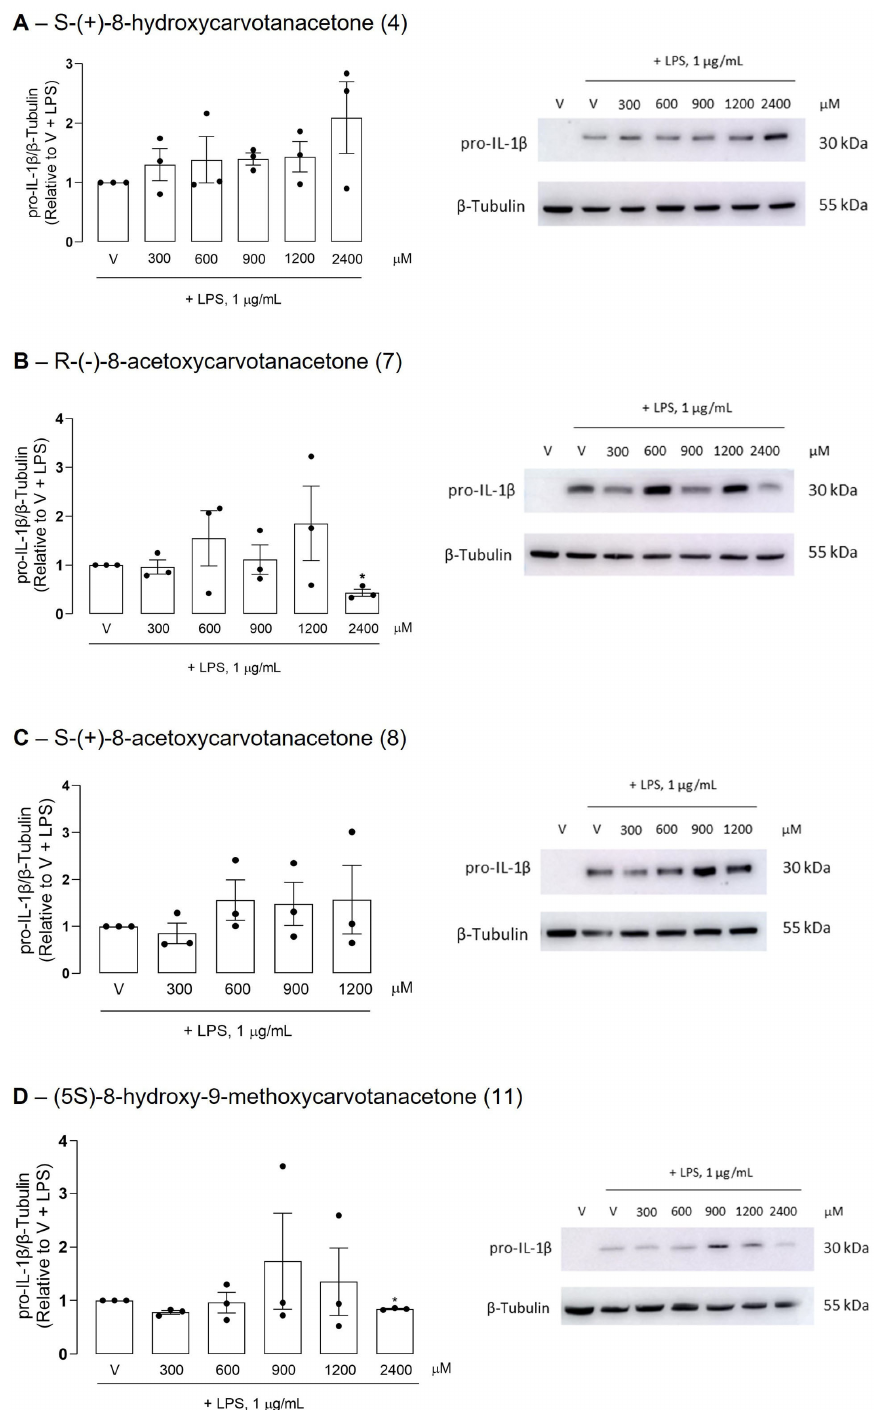
Figure 4. Effect of the test compounds on the LPS-induced pro-IL-1 β protein levels in Raw 264.7 macrophages. The cells were treated with the vehicle or the indicated concentrations of the test compounds for 1 h before the addition of 1 µ g/mL LPS for 18 h. The control cells (V) were treated with vehicle (0.1% DMSO) in the absence of LPS for the same period as for the other conditions. Representative images of Western blots are shown. Images of the full-length blots are provided in Supplementary Materials (Figures S29–S32). In the dot plots, each dot represents the result of one individual experiment and each column represents the mean ± SEM. * p < 0.05 relative to the LPS-treated